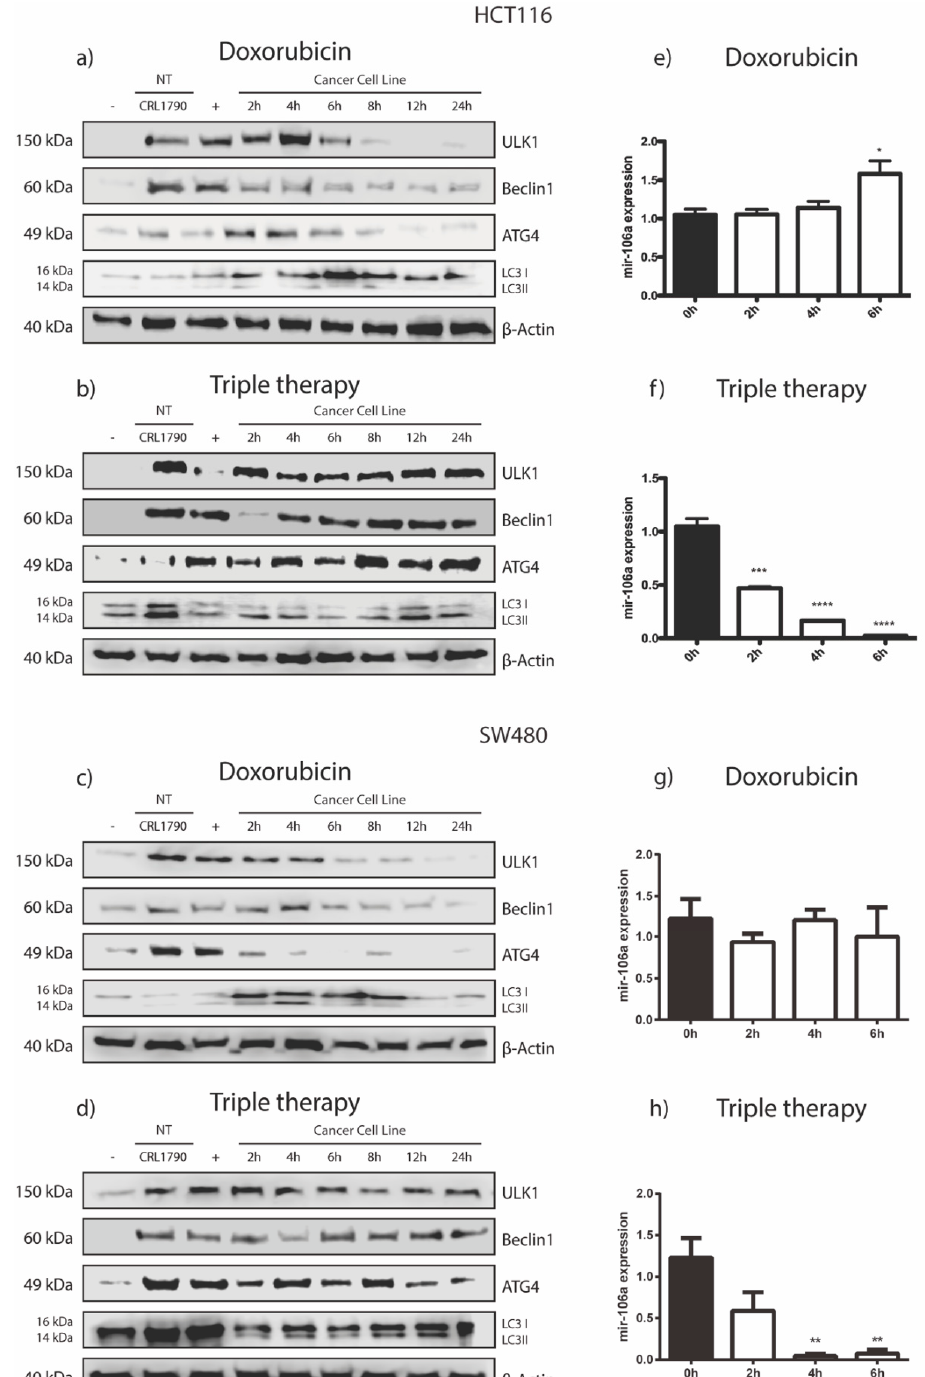
Figure 1. Detection of the proteins involved in the autophagy process in CRL1790 (non-tumor cell line), HCT116, and SW480 colon cancer cell lines. Untreated cells were the negative control, and rapamycin was the positive control (10 μ M). Western blot analysis was performed to measure autophagic flux at 2, 4, 6, 8, 12, and 24 h of exposure; ( a , c ) doxorubicin; ( b , d ) triple therapy. β -actin was used as the loading control. Correlation of miR-106a expression with the protein level expression of ULK1 in the HCT116 and SW480 cell lines. Quantitative real-time PCR shows a slight increase in miR-106a on exposure to doxorubicin ( e , g ); and a strong decline was observed in miR-106a on exposure to triple therapy ( f , h ). MiR-106a levels were calculated through the ∆∆ Ct method and normalized relative to U6 snRNA. Data are presented as the mean ± SD of three independent experiments. * p < 0.05, ** p < 0.01, *** p < 0.001, and **** p < 0.0001. NT: non-tumor